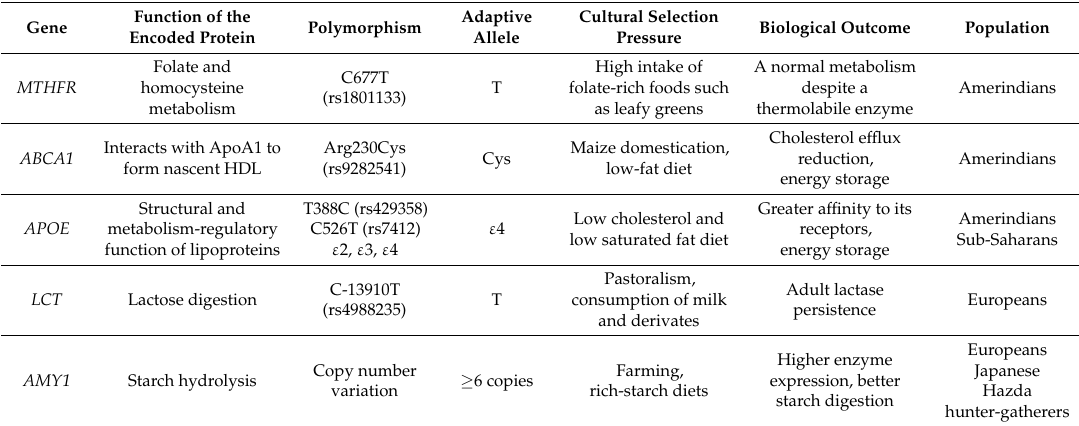
Table 1. Diet-related adaptive gene (DRAG) polymorphisms evaluated in this